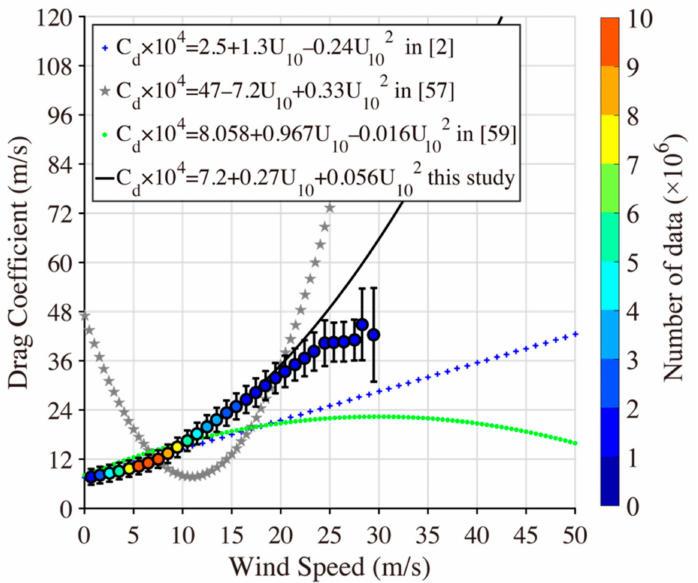
Figure 6. The fitted results based on Equation (4) using values listed in Table 2 versus SWIM- measured wind speeds in 20 typhoons. The error bars represent the standard deviations of drag coefficient C d for a 1 m/s bin of wind speed U 10 up to 50 m/s. The relations between drag coefficient C d and wind speed U 10 for three existing models adapted from [2] (blue cross), [57] (gray five-pointed star), and [59] (green dashed line), as well as the current model (black solid line).